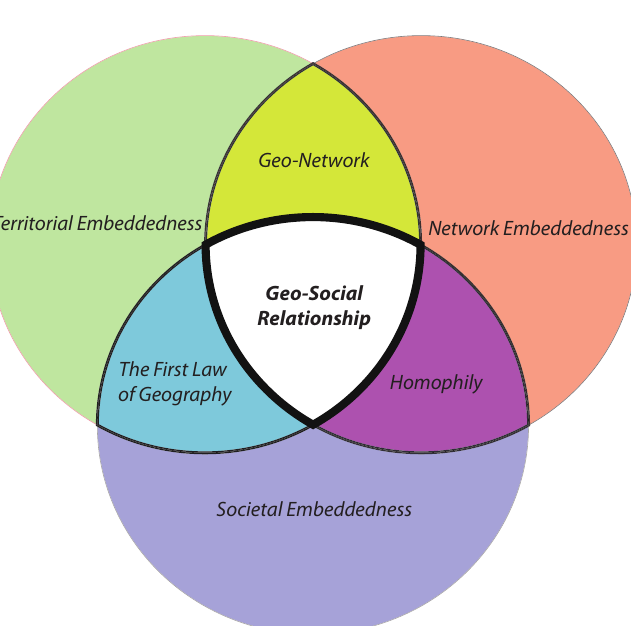
Figure 1: Proposed conceptual framework for geo-social relationships based on fundamen- tal categories of embeddedness [92]. The framework consists of three kinds of embed- dedness: territorial, network and societal. The paired overlaps each match with specific perspectives, as indicated and the joint overlap of all three areas suggests the extension of the First Law of